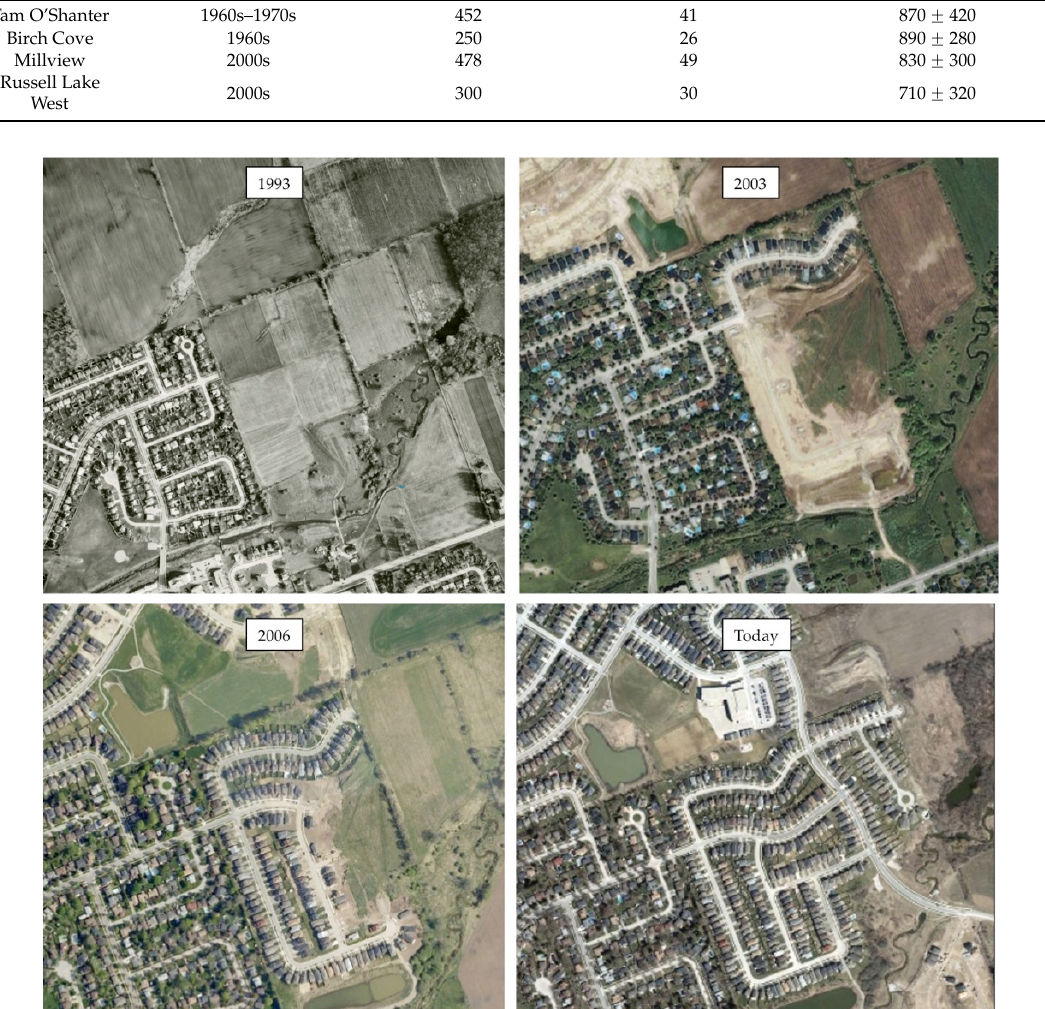
Figure 1. Aerial imagery showing the development of Stoney Creek (London, Ontario) from field to subdivision. Source: University of Western Ontario and Google Earth © DigitalGlobe.